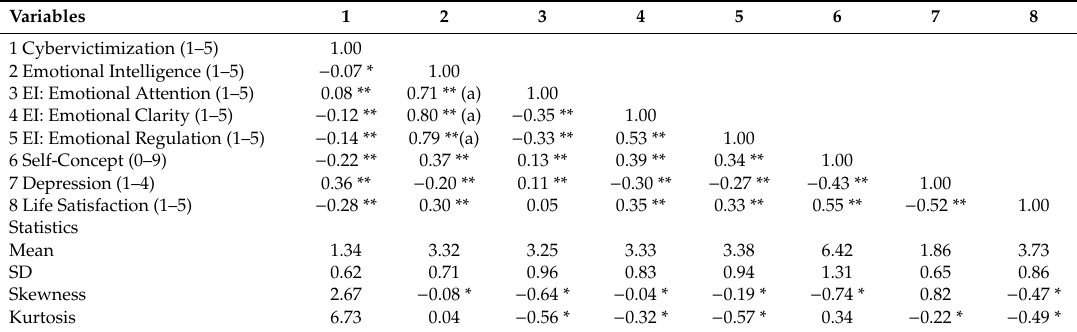
Table 1. Descriptive statistics and Spearman correlations for the variables included in the study.